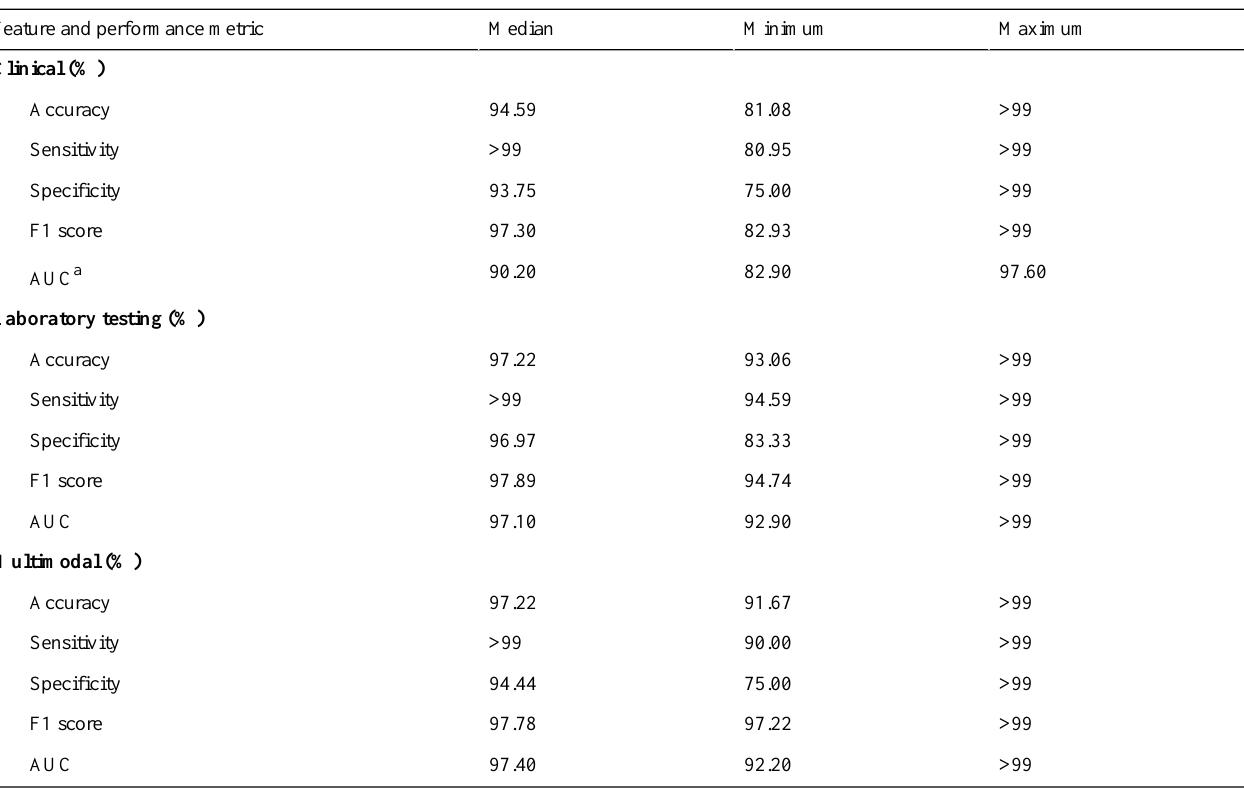
Table 1. Performance of the random forest model with multimodal features. The results are based on 100 runs. In each run, 80% of the data was randomly selected as the training set and 20% as the testing set. The table shows the model performance on the testing set only. MaximumMinimumMedianFeature and performance metric